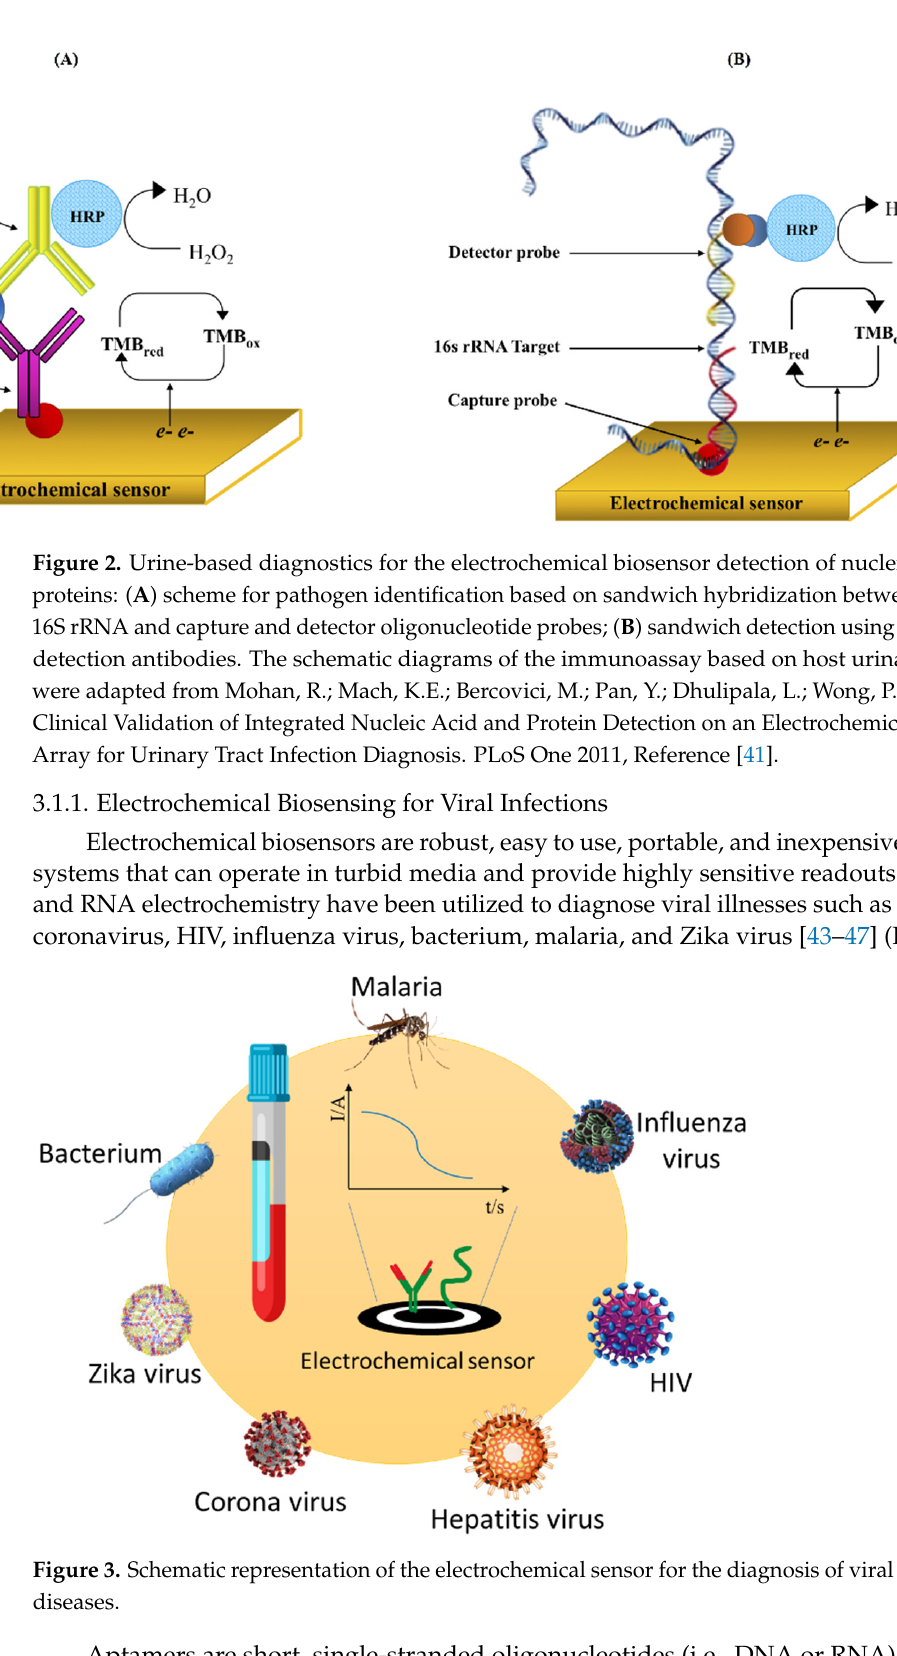
Figure 3. Schematic representation of the electrochemical sensor for the diagnosis of viral and trop- ical diseases.